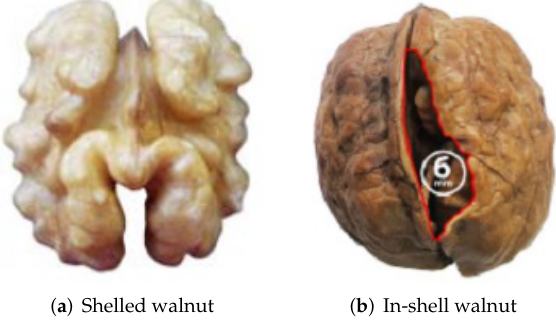
Figure 1. Main walnut products.